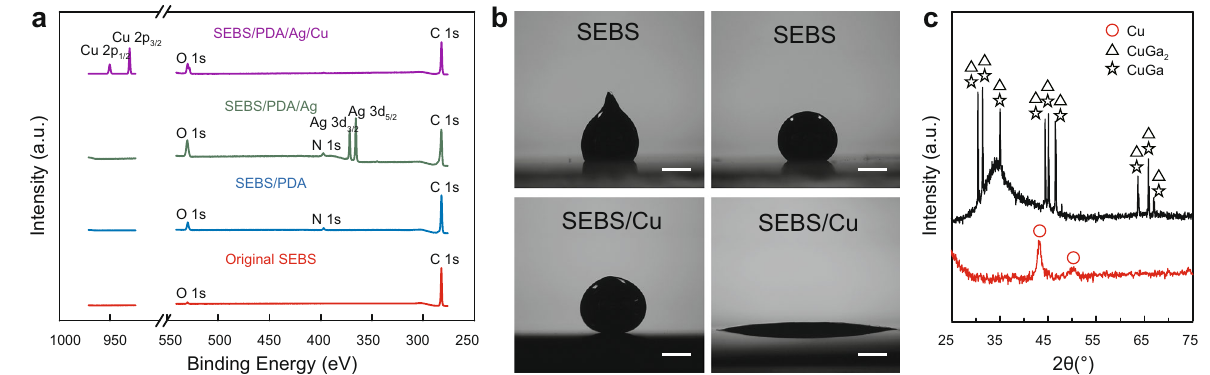
Fig. 2 Characterizations to reveal the patterning mechanism. a XPS spectra acquired from each critical step to achieve electroless deposition of Cu fi lm on SEBS substrate. b Contact angle images of liquid metal droplets on pristine and Cu-covered SEBS substrates before (left) and after (right) treatment in dilute HCl. Scale bar: 1 mm. c XRD spectra acquired from electroless plated Cu fi lm (red) and liquid metal pattern